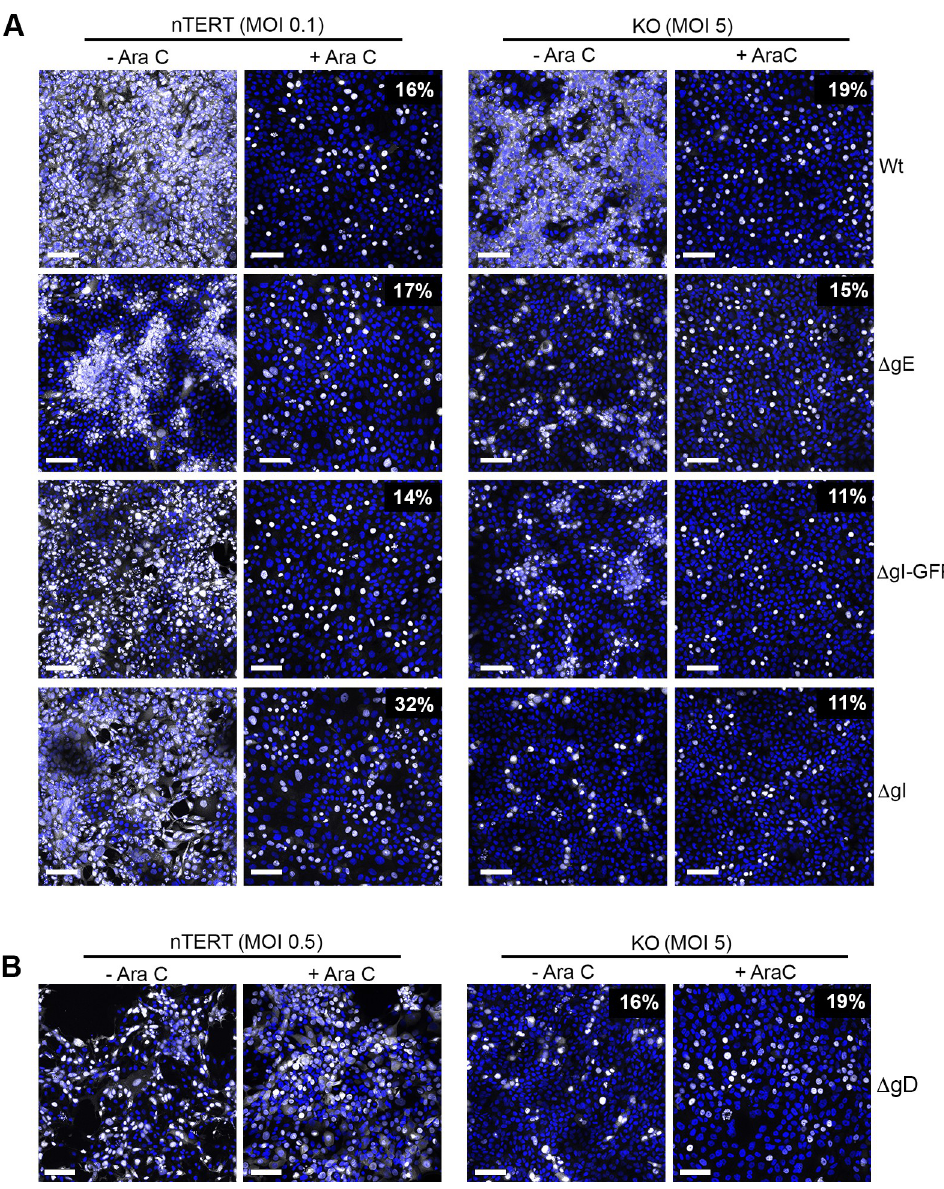
Fig 8. Spread phenotype of HSV1 lacking glycoproteins E, I or D in nectin1 KO cells. (A) nTERT and KO cells grown on coverslips were infected with HSV1 viruses as indicated at MOI 0.1 for nTERT and MOI 5 for KO cells in the absence or presence of 100 ng/ml AraC. Cells were fixed at 16 h, permeabilised and stained for ICP4 (white). (B) nTERT and KO cells grown on coverslips were infected with HSV1 lacking gD that had been propagated on a complementing gD cell-line, at MOI 0.5 for nTERT and MOI 5 for KO cells in the absence or presence of 100 ng/ml AraC for the course of the experiment. Cells were fixed at 16 h, permeabilised and stained for ICP4 (white). Nuclei were stained with DAPI (blue). Scale bar = 100 μ m. Percentages refer to number of ICP4 positive nuclei, determined using NIH ImageJ